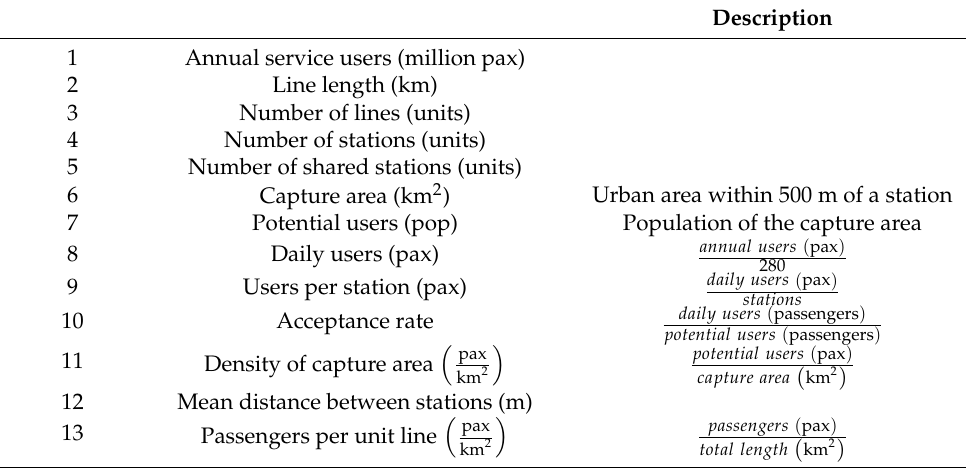
Table 1. Parameters and ratios of the